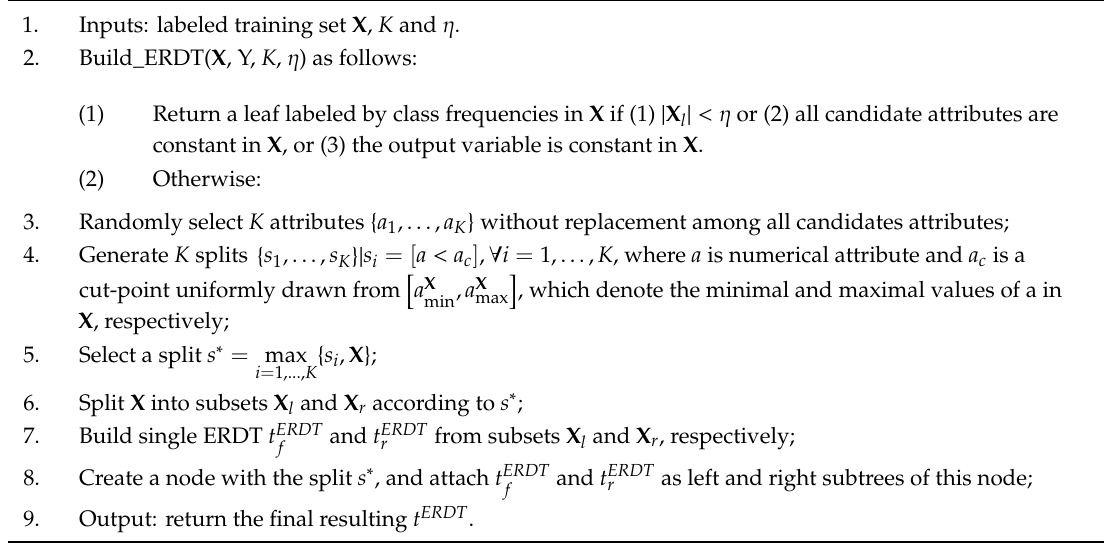
Algorithm 1 Algorithmic steps to build an extremely randomized decision tree (ERDT)